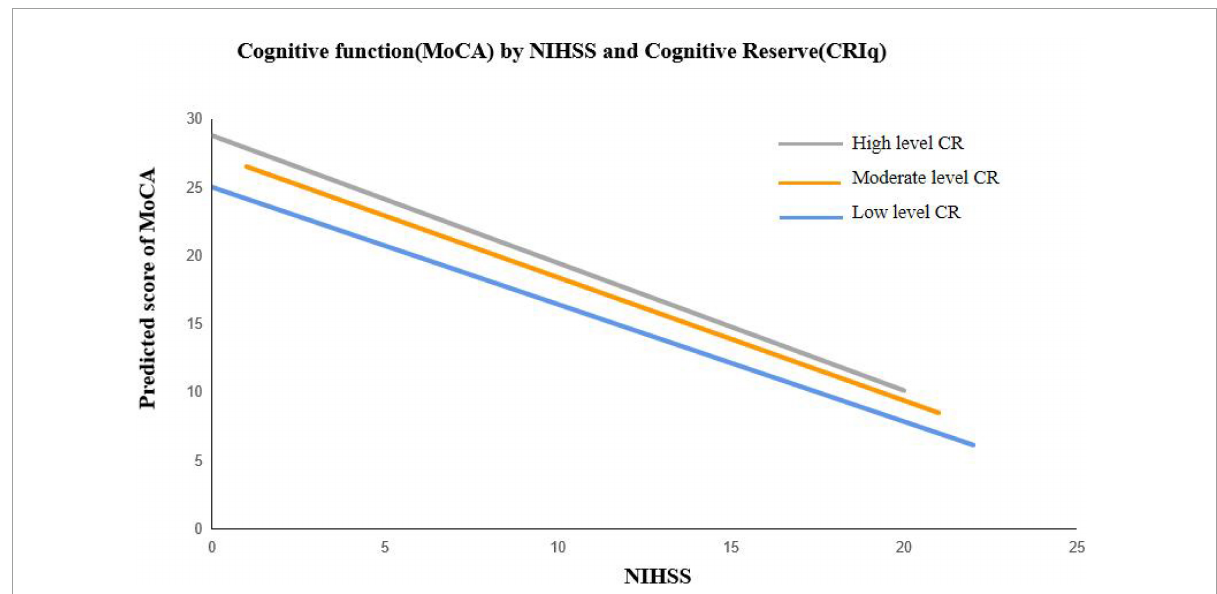
FIGURE2 Cognitive function (MoCA) of AIS patients by stroke severity (NIHSS) and cognitive reserve. (CRIq) Cognitive reserve was stratified into low (CRIq ≤ 84), moderate (85 ≤ CRIq ≤ 114), and high (CRIq ≥